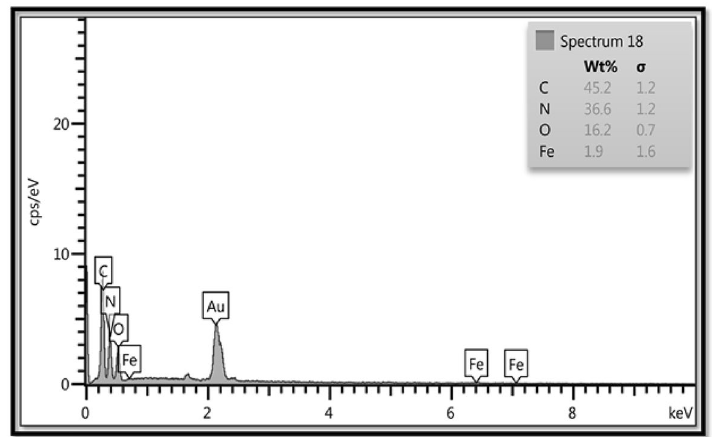
Figure 6. EDX spectrum of the Fe 3 O 4 /SiO 2 -TMA-Me nanocomposite ( 1 ).